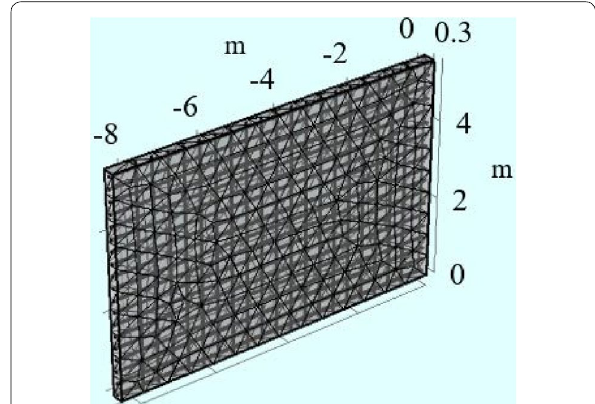
Fig. 1 3D mesh model of the barricade (dimension in m).